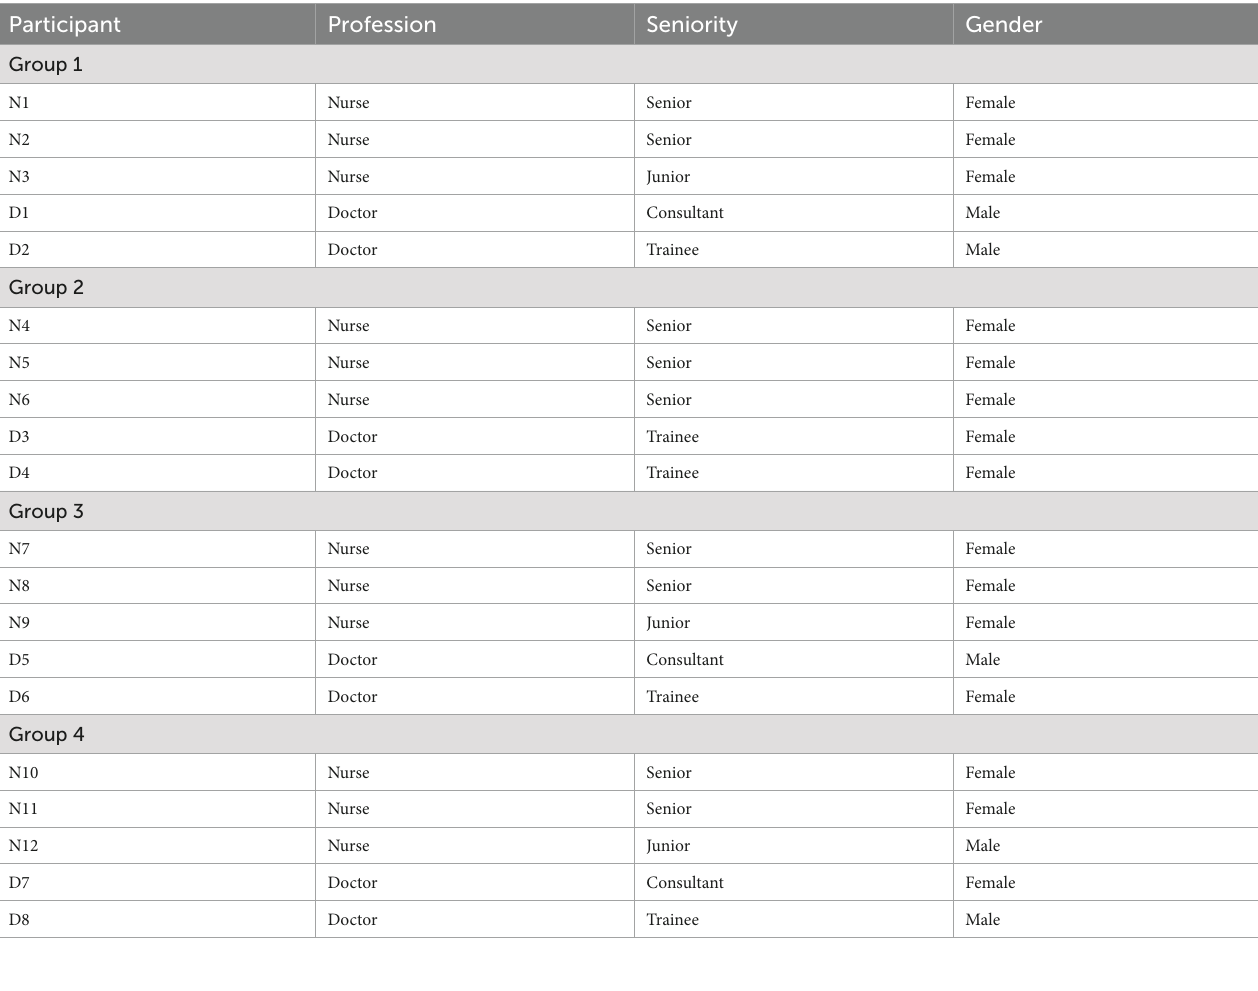
TABLE 2 Participant information.